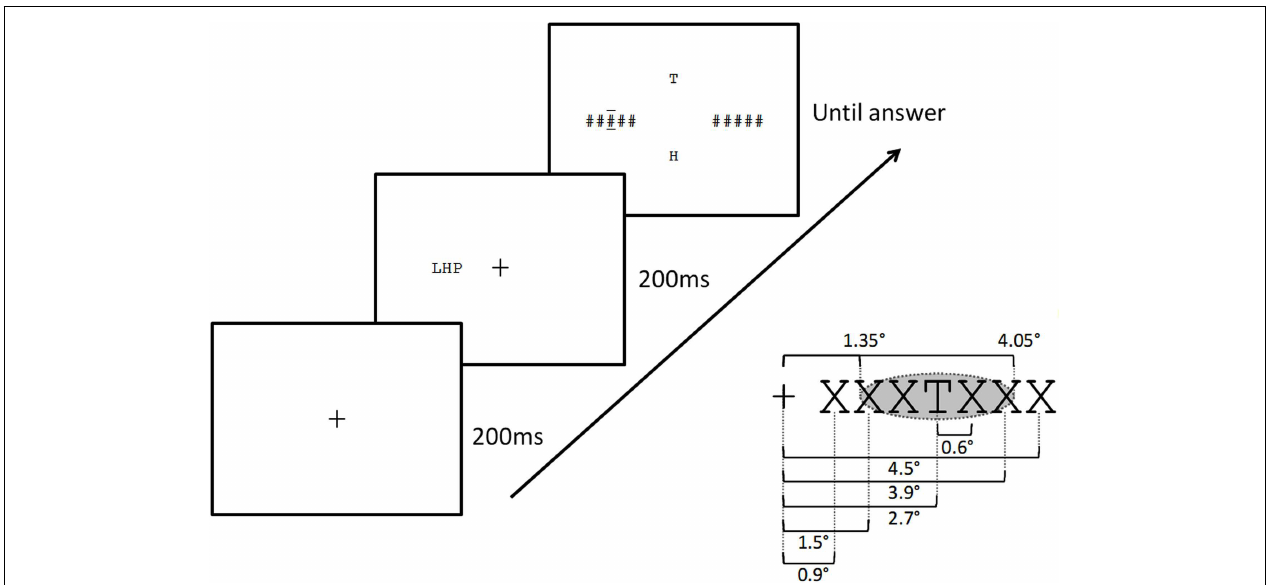
and below the target location, plus the presentation of two-alternative letters for the 2AFC response. Inter-letter spacing, eccentricity of the closest letter and the central target letter, and theoretical extent of the crowding zone according to Bouma’s law (shaded ellipse) are shown bottom